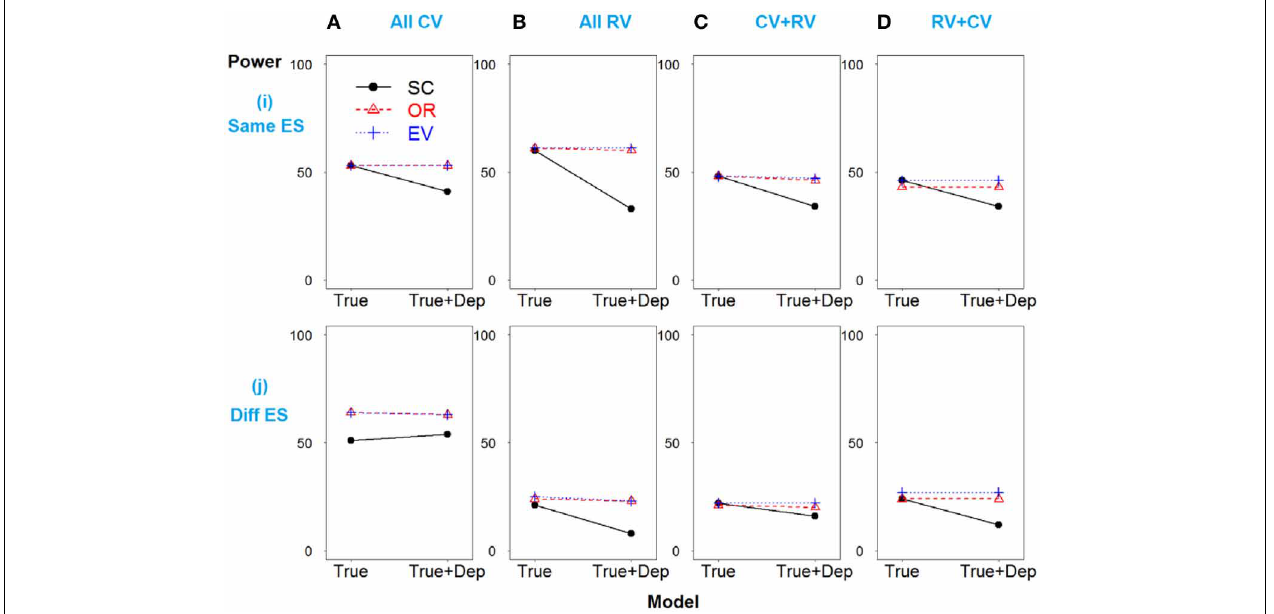
FIGURE 3 | Power comparison for the strong linkage disequilibrium model when SNPs 2 and 3 are dependent. Panels by column: (A) SNPs 1 and 2 are common variants. (B) SNPs 1 and 2 are rare variants. (C) SNP 1 is